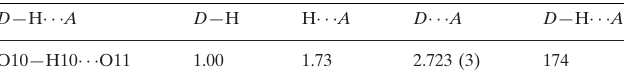
Hydrogen-bond geometry (A˚ , (cid:3)